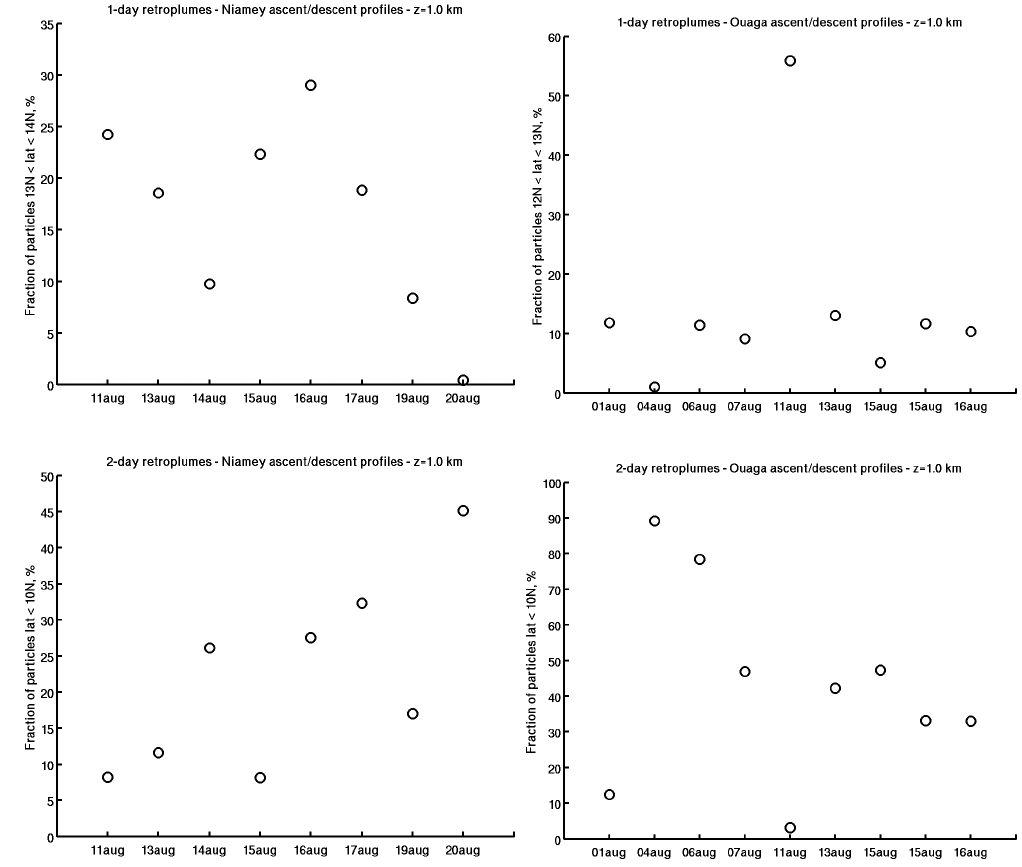
Fig. 7. Daily variability of local stagnation and northward transport from the forest using backward FLEXPART runs with releases at observation time t0 and in the altitude range 0.5–1.5km above Niamey (right column) and Ouagadougou (left column). Top panels (a) , (b) : is the fraction of particles remaining within the 1olatitude band around the city at t0–1 day. Bottom panels (c) , (d) : is the fraction of particles coming from latitudes < 10 ◦ N at t0–2 days.